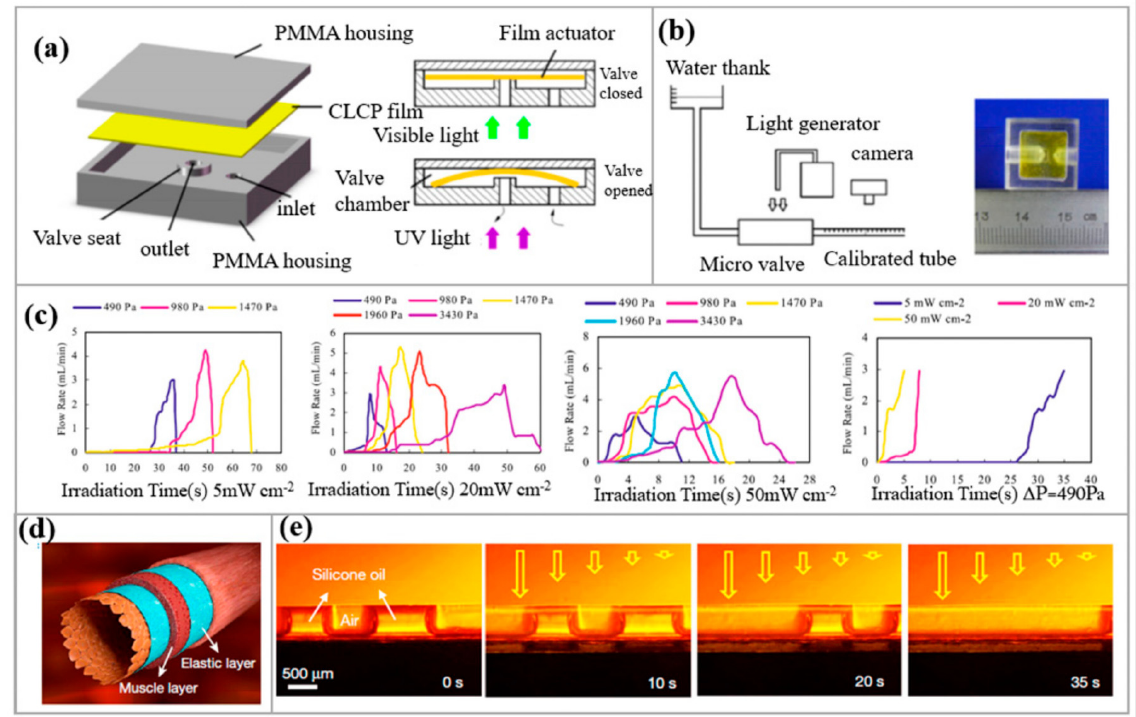
Figure 10. ( a ) Schematic diagram of structure model of light − actuated liquid crystal film micro-valve. ( b ) Cross-sectional schematic diagram and working principle of light-actuated liquid crystal film micro − valves. ( c ) The relationship between fluid flow and irradiation time under different conditions [95]. Permission from Springer Nature. ( d ) Schematic diagram of the artery wall structure. ( e ) The light-induced movement of the silicone oil plug in a tubular actuator fixed on the substrate [96]. Permission from Springer